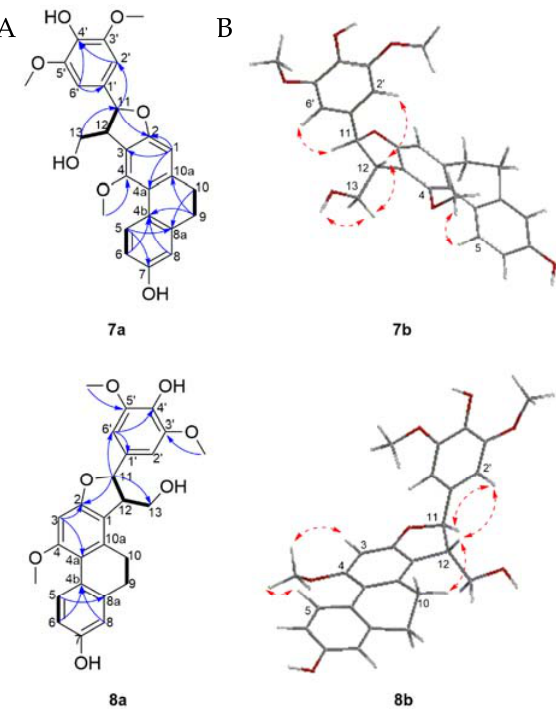
Figure 5. ( A ) Selected COSY (plain bonds) and HMBC (blue arrows) correlations of compounds 7 – 8 ; ( B ) Energy minimized 3D structures and NOESY correlations (red dashed arrows) of compounds 7 – 8